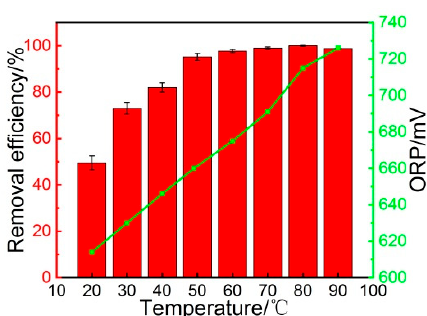
Figure 3. E ff ect of the temperature of the NaClO 2 solution on NO removal e ffi ciency and Figure 3. Effect of the temperature of the NaClO 2 solution on NO removal efficiency and oxidation— oxidation—reduction potential. Reaction conditions: NaClO 2 concentration 0.008 mol / L; initial reduction potential. Reaction conditions: NaClO 2 concentration 0.008 mol/L; initial pH 3; NO inlet pH 3; NO inlet concentration 500 ppm; N 2 balance, with a total flow rate of 1.5 L / min. concentration 500 ppm; N 2 balance, with a total flow rate of 1.5 L/min.